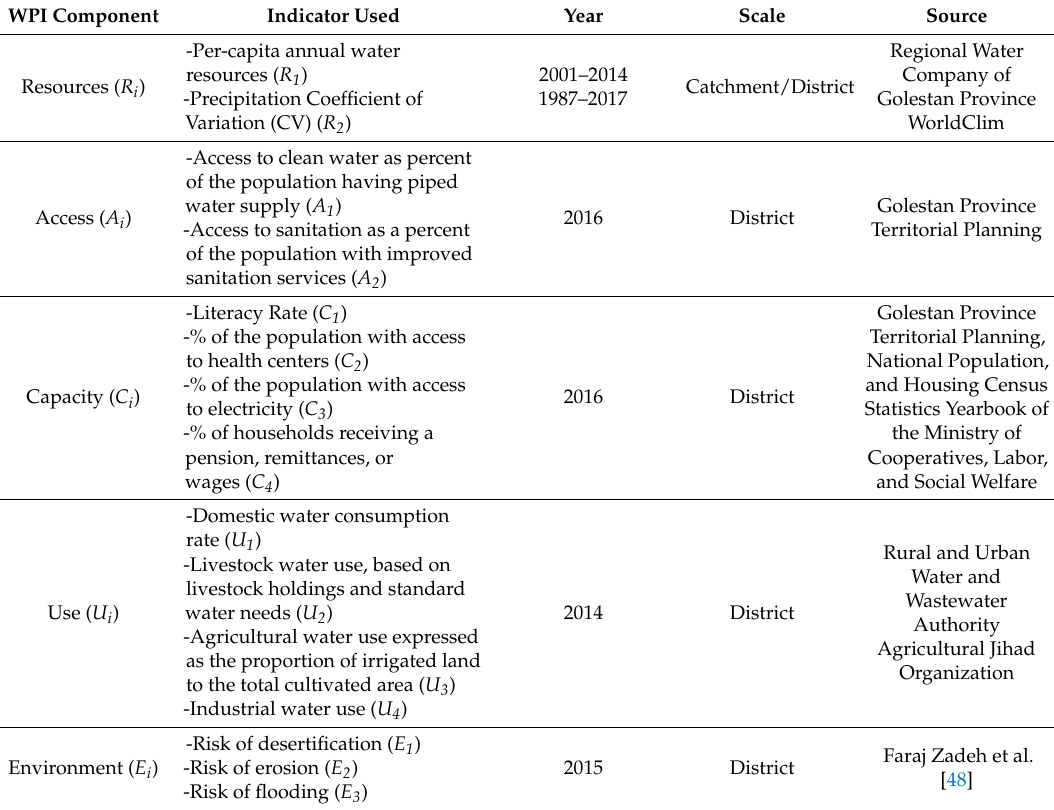
Table 1. WPI component variables for water scarcity assessment over the study